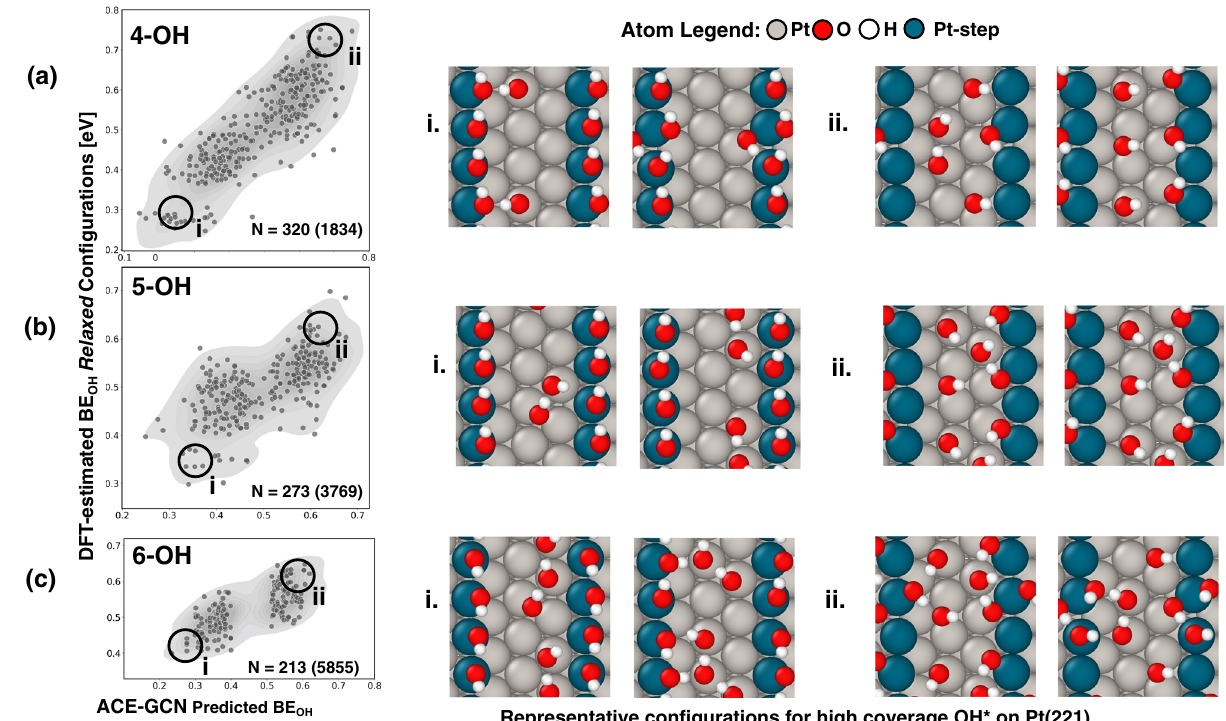
Representative configurations for high coverage OH* on Pt(221) Fig. 4 | Screening high coverage OH* con fi gurations on Pt(221). Sub fi gures ( a ), cell, 1/3 to 1/2ML) is trained on con fi gurations with lower coverages (see text for ( b ), and ( c ) show scatter plots for average OH* binding energies of unrelaxed details). On the right side of the scatter plots, representative stable and unstable con fi gurations, as predicted by ACE-GCN (x-axis), with respect to DFT-relaxed atomic con fi gurations, from regions ‘ i ’ and ‘ ii ’ depicted in the scatter plots, are energiesofthecorrespondingstructures(y-axis).Arepresentativeareaofchemical shown. A few relaxed con fi gurations showing OH* species dissociation after DFT space relevant for unstable and stable con fi gurations is depicted on the scatter relaxation were not included in the plots or model retraining (analysis of dis- plots (marked ‘ i ’ and ‘ ii ’ ). Numbers in the inset show the total number of DFT- sociated con fi gurations is discussed inthe Supplementary Information S5).Source relaxed con fi gurations compared to the total possible structures enumerated by data are provided as a Source Data fi SurfGraph. The ACE-GCN model for each succeeding coverage (4/5/6 OH* per unit on the right side of Fig. 4b, c, for both 5 and 6 OH* cases (5/12 and 1/